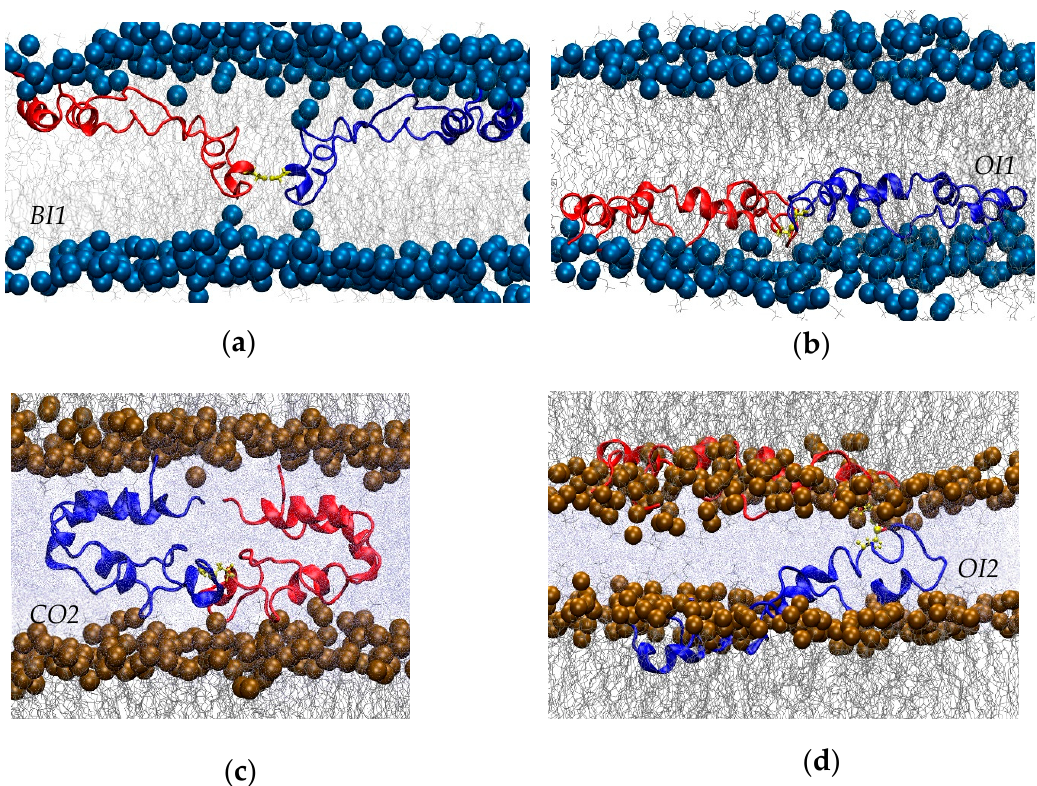
Figure 2. Close-ups of initial conformations of the four simulations. ( a ) “Bent In One Bilayer” (BI1). ( b ) “Open In One Bilayer” (OI1). ( c ) “Closed Out Two Bilayers” (CO2). ( d ) “Open In Two Bilayers” (OI2). The inter-subunit disulfide is shown in yellow, the phosphorus atoms in the lipid headgroups as solid spheres, lipid chains in grey, and water (only shown in panels ( c , d ) in pale blue.